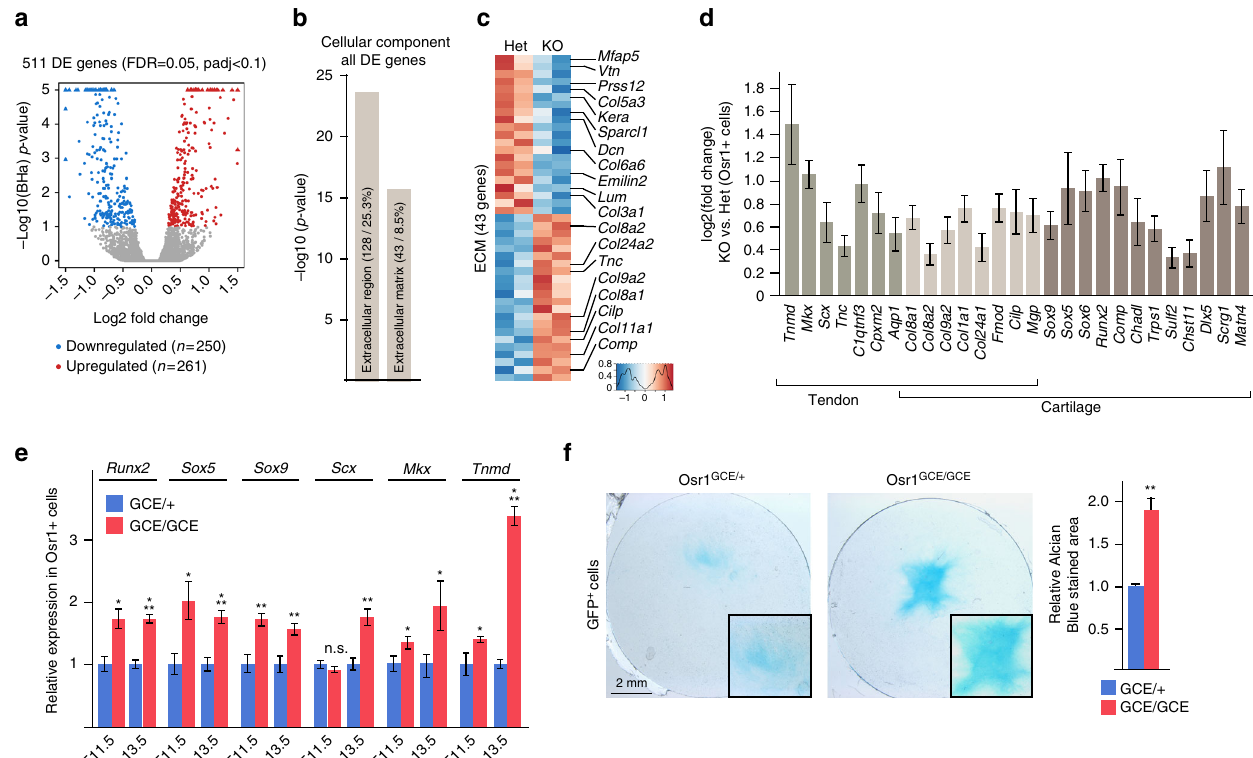
Fig. 6 Osr1 controls ECM gene expression in a bimodal way and is required to prevent ectopic cartilage / tendon gene expression. a Volcano plot depiction of transcriptome analysis of FACS-sorted Osr1 + cells from limbs of E13.5 Osr1 GCE/ + or Osr1 GCE/GCE embryos shows differentially expressed (DE) genes between Osr1 GCE/ + and Osr1 GCE/GCE limb cells. 511 DE genes were identi fi ed with a false discovery rate of 0,05 that showed a log2 fold change over 1,2 or below 0,8 and a Benjamini-Hochberg adjusted p -value (padj) < 0,1. b GO analysis of all DE genes for “ cellular component ” showed enrichment for the indicated terms. c Heatmap depiction of all genes belonging to the term “ extracellular matrix ” (ECM). Selected ECM genes are indicated. d Bar graph plot for genes selected from all DE genes for their cartilage and/or tendon- speci fi c expression pattern in embryo; note that all cartilage/tendon genes are upregulated in Osr1 mutants. e Con fi rmation of upregulation of Runx2 , Sox5 and Sox9 (cartilage genes) and Scx , Mkx and Tnmd (tendon genes) in E11.5 and E13.5 Osr1 de fi cient cells by RT-qPCR ( n = 4). f Chondrogenic culture of Osr1 GCE/+ and Osr1 GCE/GCE cells. Chondrogenic matrix is stained with Alcian blue, histomorphometric quanti fi cation is shown on the right. ( n = 3). Error bars represent log2 fold change standard error (ifcSE) estimated by DESeq2 in d and s.e.m. in e , f . T-test: * = p < 0.05; ** = p < 0.01; *** = p < 0.001. N-numbers indicate biological replicates, i.e. samples from different